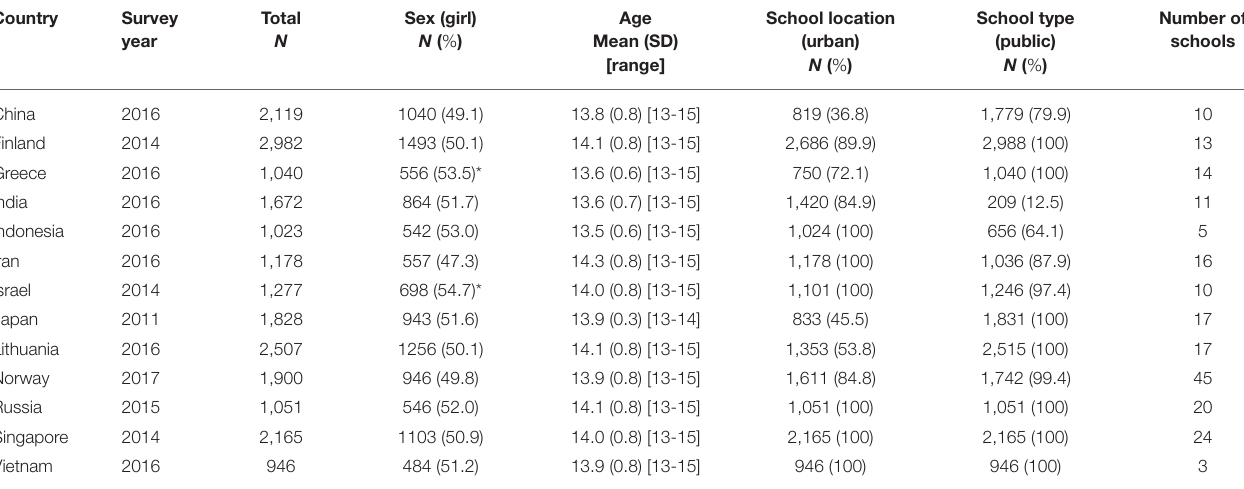
TABLE 1 | Demographic characteristics of the 13 countries.